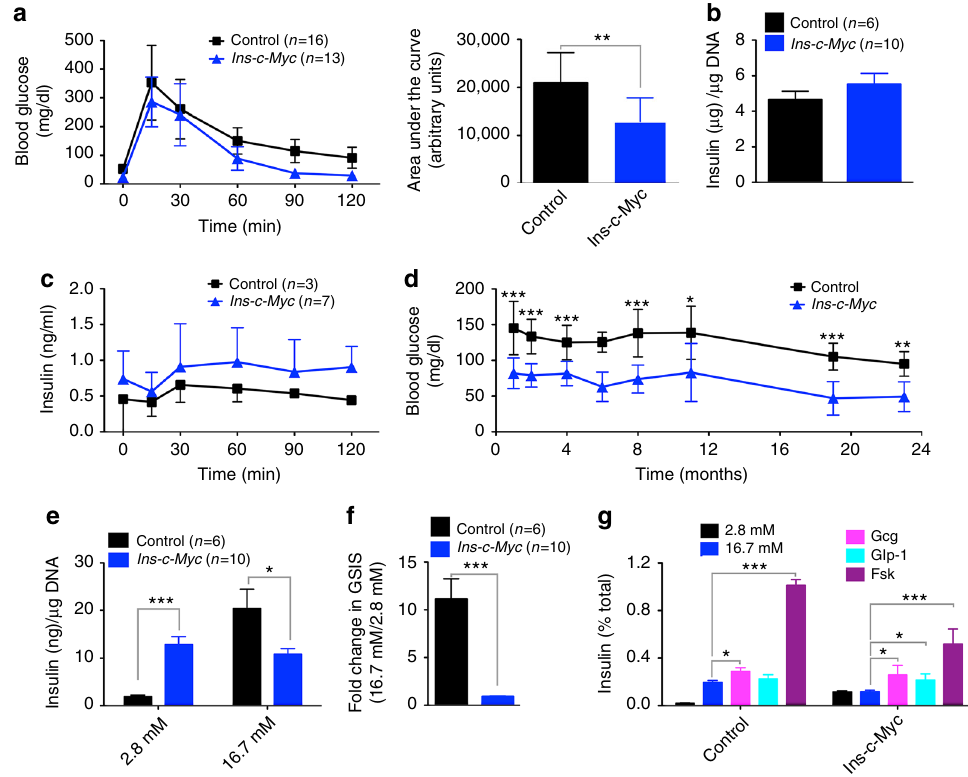
Fig. 3 Imprecise glucose regulation in mice with stabilized c-Myc in β cells. a Glucose tolerance tests on three-month-old mice Ins-c-Myc animals ( n = 13) as compared to littermate controls ( n = 16). The corresponding area under the curve is noted. Error bars indicate ± SD. ** p < 0.005, Student ’ s t test. b Total insulin content in islets from transgenic (red bar, n = 10) and control (black bar, n = 6) animals. Error bars indicate ± SEM. c In vivo IPGTT on the transgenic ( n = 7) and controls ( n = 3) mice. Error bars indicate ± SD. d Measurement of glycemia under fed conditions in Ins-c-Myc and control animals. Numbers of control and transgenic animals analyzed at 1, 2, 4, 6, 8, 11, 19, and 23 months were: 22, 21; 27, 27; 22, 20; 6, 2; 5, 7; 5, 6; 17, 18; and 6, 5 respectively. Error bars indicate ± SD. * p ≤ 0.05, ** p < 0.005, *** p < 0.0005, Student ’ s t test. e In vitro glucose stimulated insulin secretion in islets from transgenic (red bars, n = 10) and control (black bars, n = 6) animals at basal (2.8 mM), and high (16.7 mM) glucose levels. Error bars indicate ± SEM. * p ≤ 0.05, *** p < 0.0005, Student ’ s t test. f Stimulation index of insulin secretion in transgenic islets (red bar, n = 10) as compared to controls (black bar, n = 6). Error bars indicate